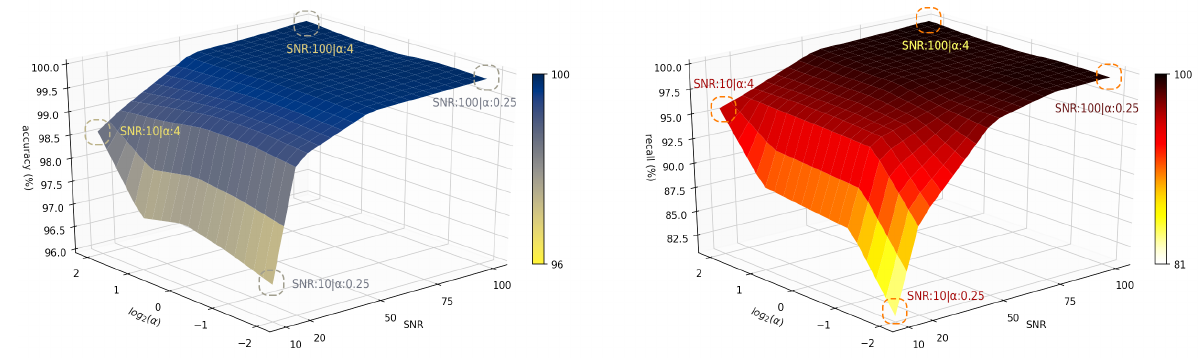
Figure 11. Accuracy ( left ) and Recall ( right ) performances of GAN-CLSTM-ELM in different SNR and α